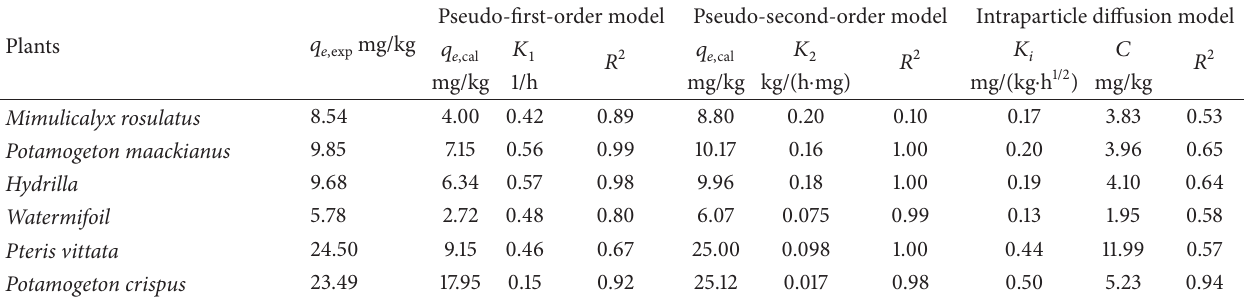
Table 2: Kinetic parameters for pseudo-first-order, pseudo-second-order, and intraparticle diffusion model models for As (III) adsorption at 13 ∘ C.